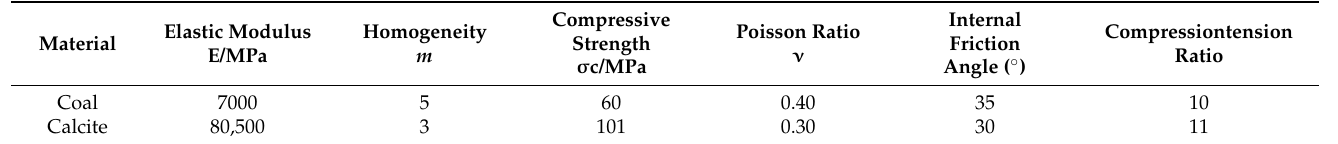
Table 1. Parameters of coal numerical model [41,42].